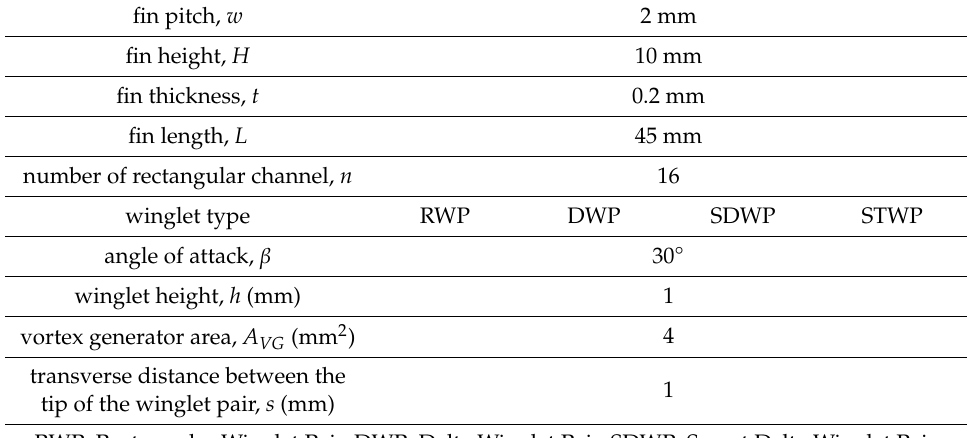
Table 1. The detailed specification of the heat sink and the